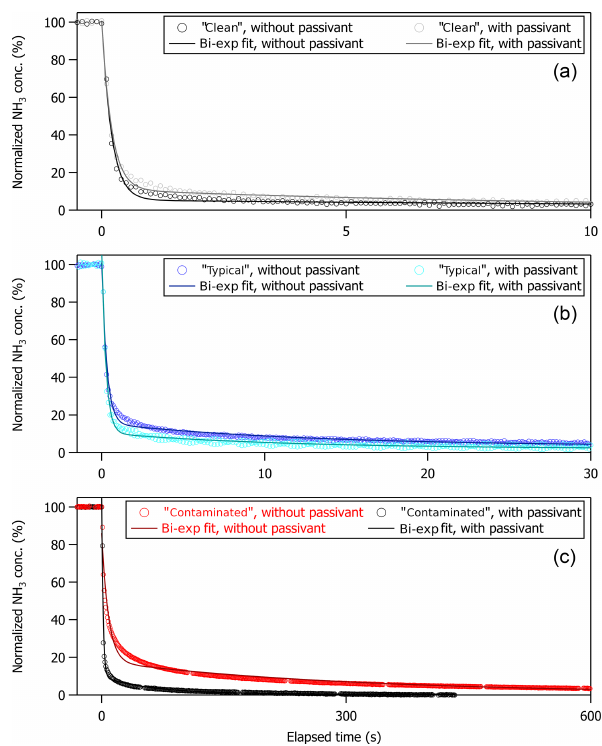
Figure 5. Normalized NH 3 signal (in %) versus elapsed time (in seconds) following a step change in NH 3 mixing ratio generated by switching off calibration gas at t = 0s. Temporal profiles and asso- ciated bi-exponential fits are shown for the non-passivated and pas- sivated instrument operated under (a) clean, (b) typical, and (c) con- taminated sampling surface conditions. Fits ranged from t 0 to 400, 1000, and 3000s for the clean, typical, and contaminated cases, re- spectively, in accord with the elapsed time collected for each time